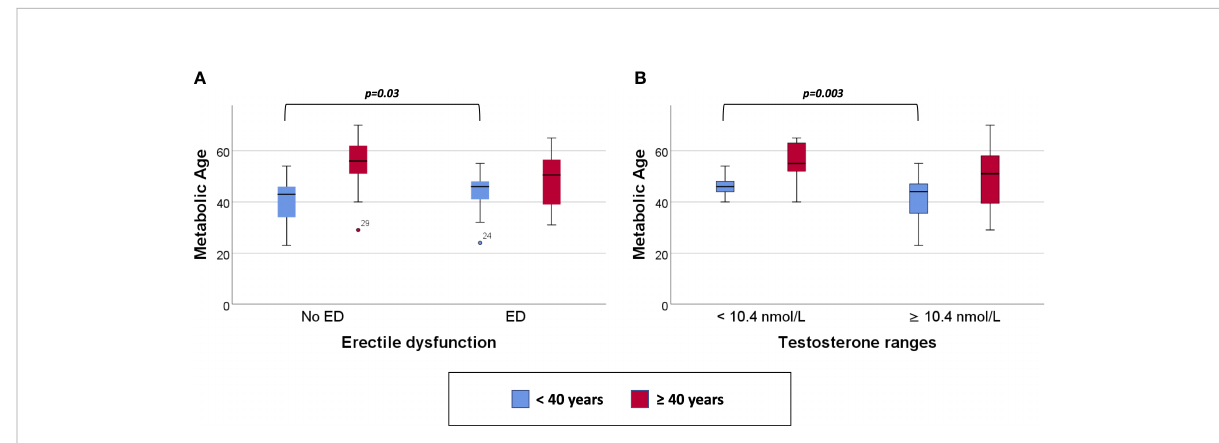
FIGURE 2 Clustered Box plot for: Metabolic Age by sexual function (A) and serum testosterone level (B) in participants < or ≥ 40 years of age.